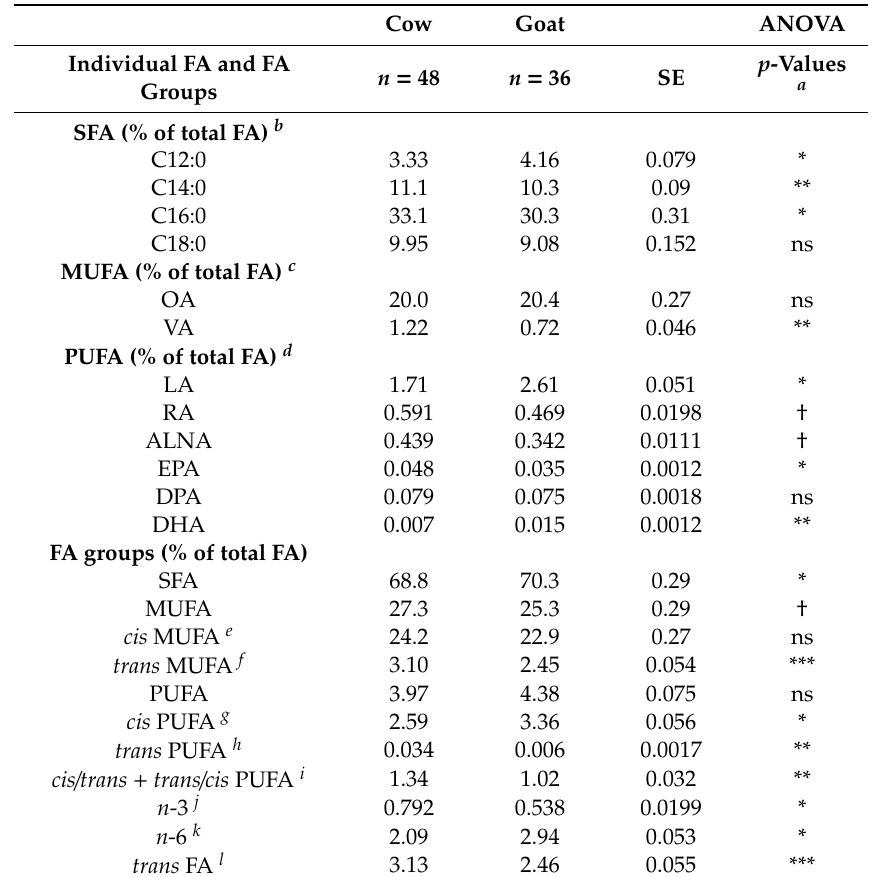
Table 2. Means (and average SE) and ANOVA p -values for the fatty acid (FA) profile of cow and goat retail milk collected throughout the